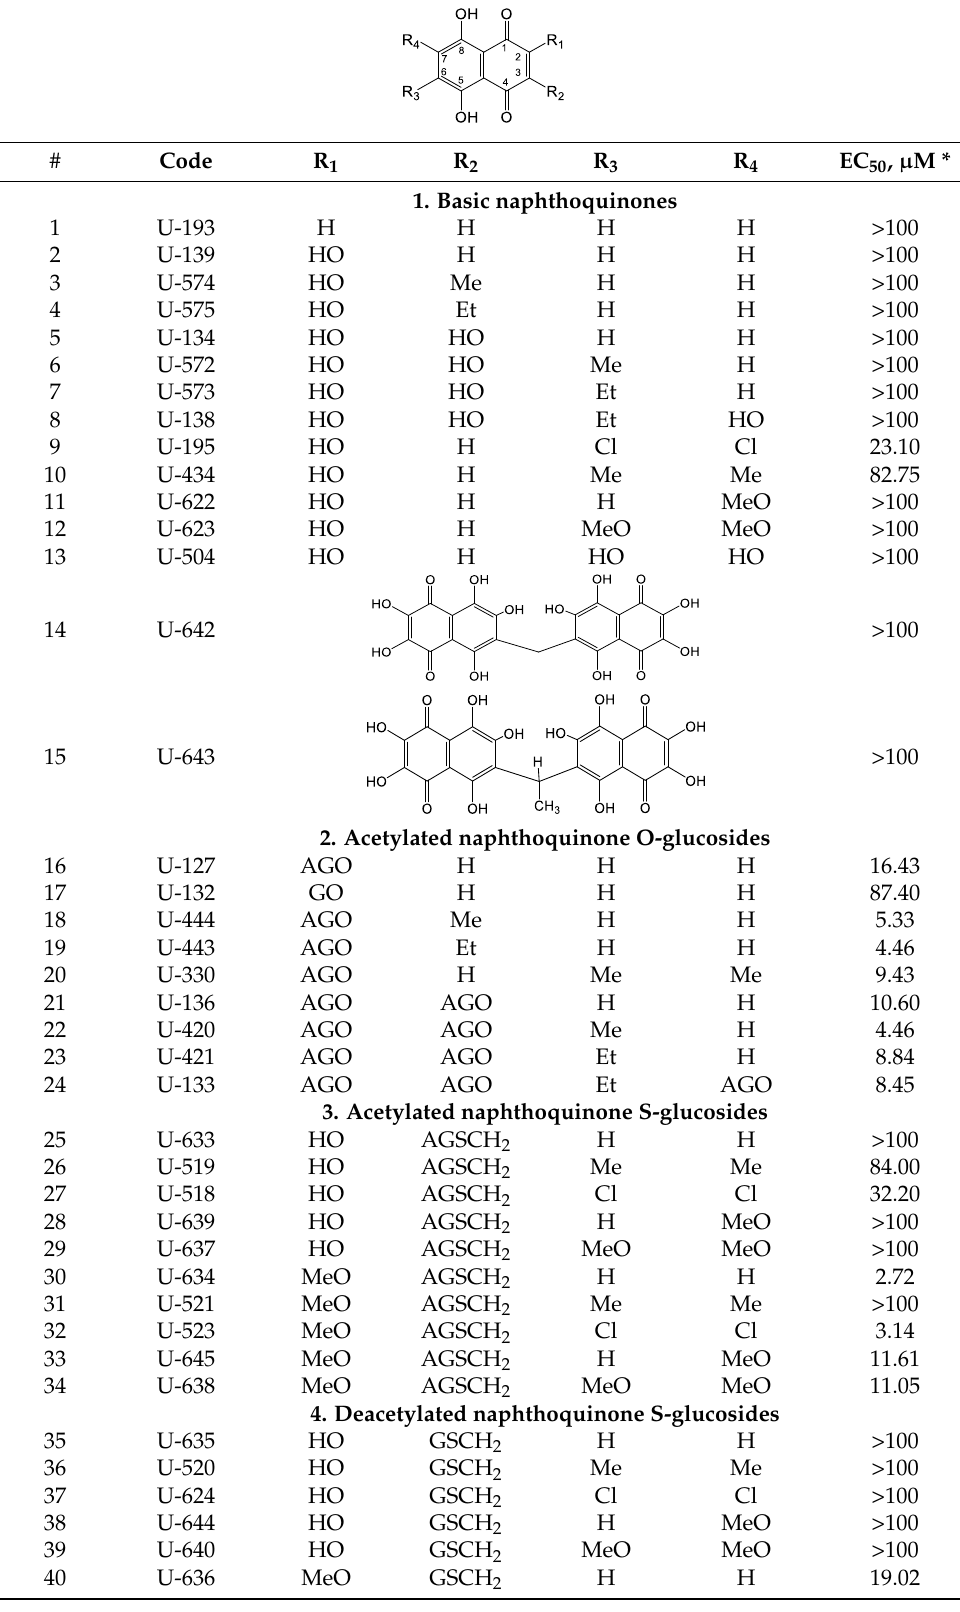
Table 1. Chemical structures of studied 5,8-dihydroxy-1,4-naphthoquinone derivatives.